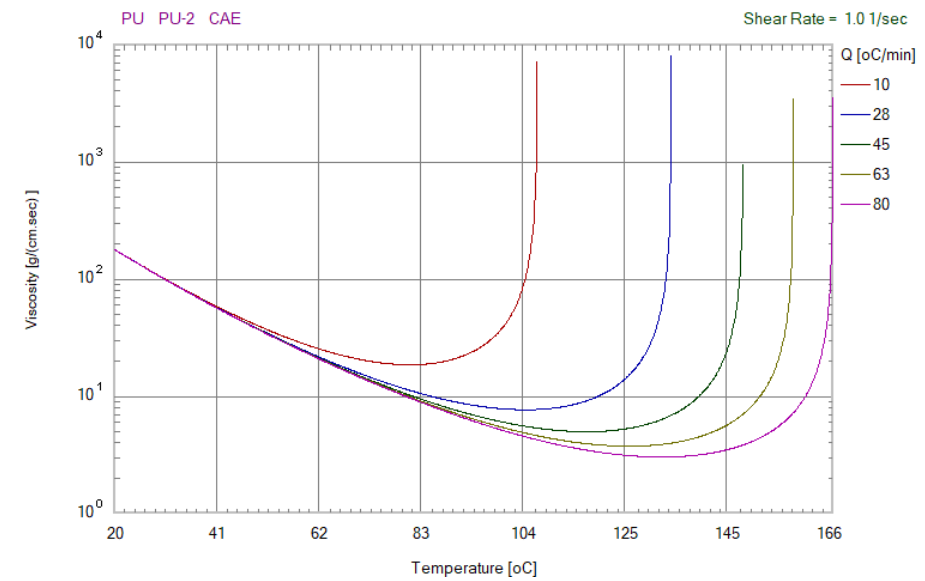
Figure 5. Viscosity as a function of the temperature of the polyurethane molding material.